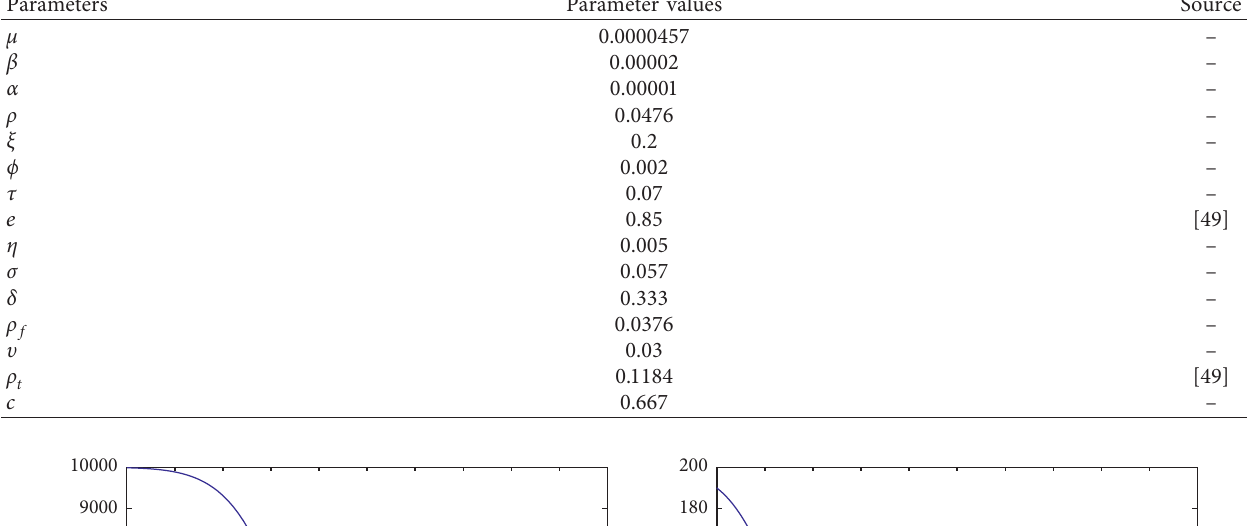
Table 1: Parameter values used for numerical